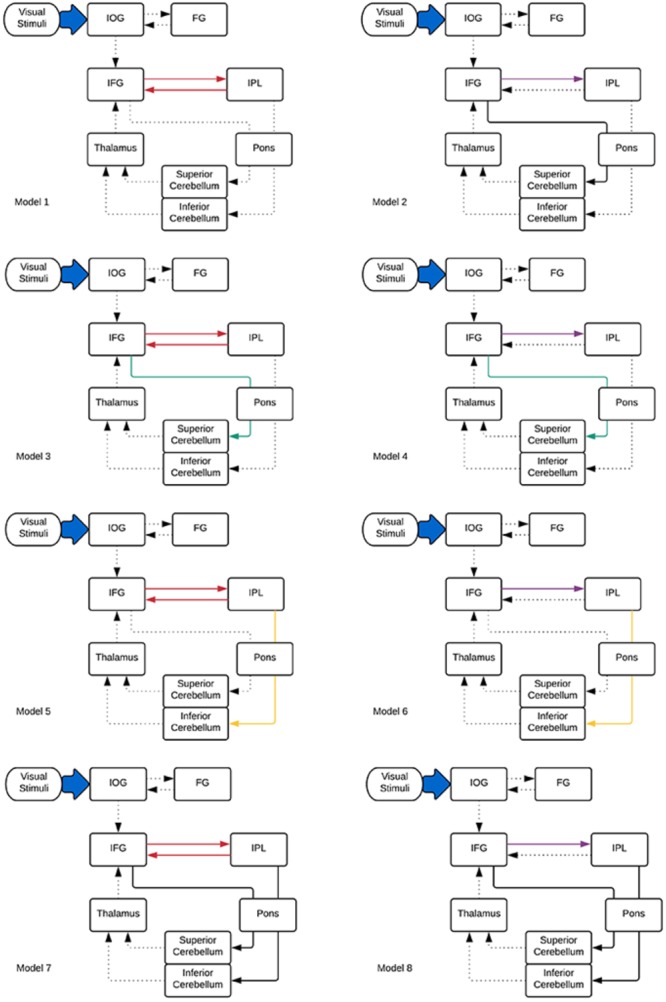
DCM models informed by the tractography results specified for effective connectivity analysis. Dotted lines indicate intrinsic effects, red, green, yellow, and purple lines represent the modulatory effects. Driving input is indicated by the blue arrow.